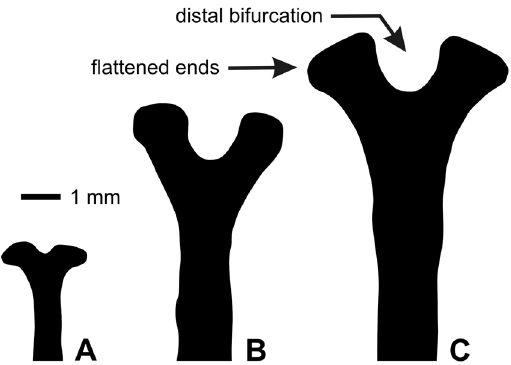
Figure 11. Distal compass ends of Tripneustes kermadecensis n. sp. ( A ) Paratype NHMW-Geo 2017/0016/0001, ( B ) holotype AIM MA73563, and ( C ) AIM